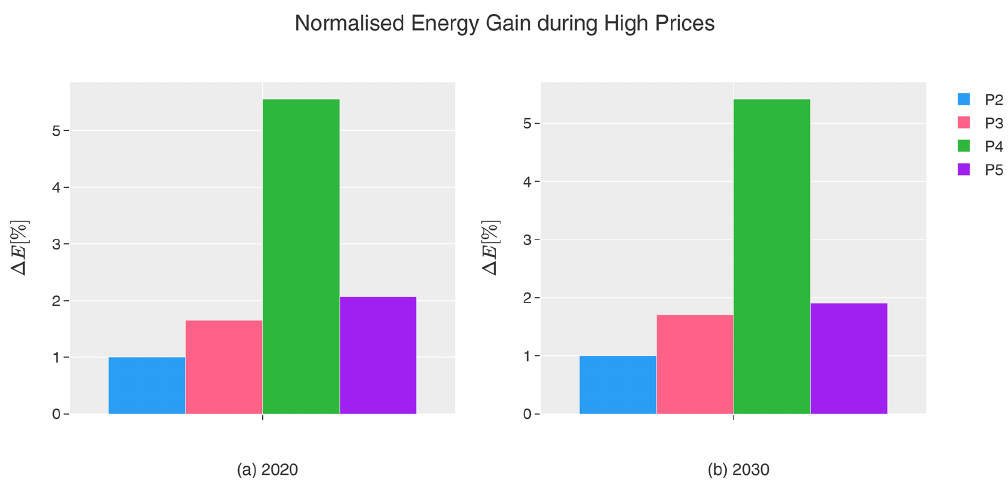
Figure 8. Energy gain ( (cid:49)E ) in percentage when using wind farm flow control (WFFC) in simulations with the wind inflow and price information as shown in Fig. 1 for 2020 (a) and 2030 (b) , with respect to the production under normal operation without WFFC, calculated using Eq. (6) for each participant, and where normalisation is performed per bin. Each bar indicates the results for one of the participants